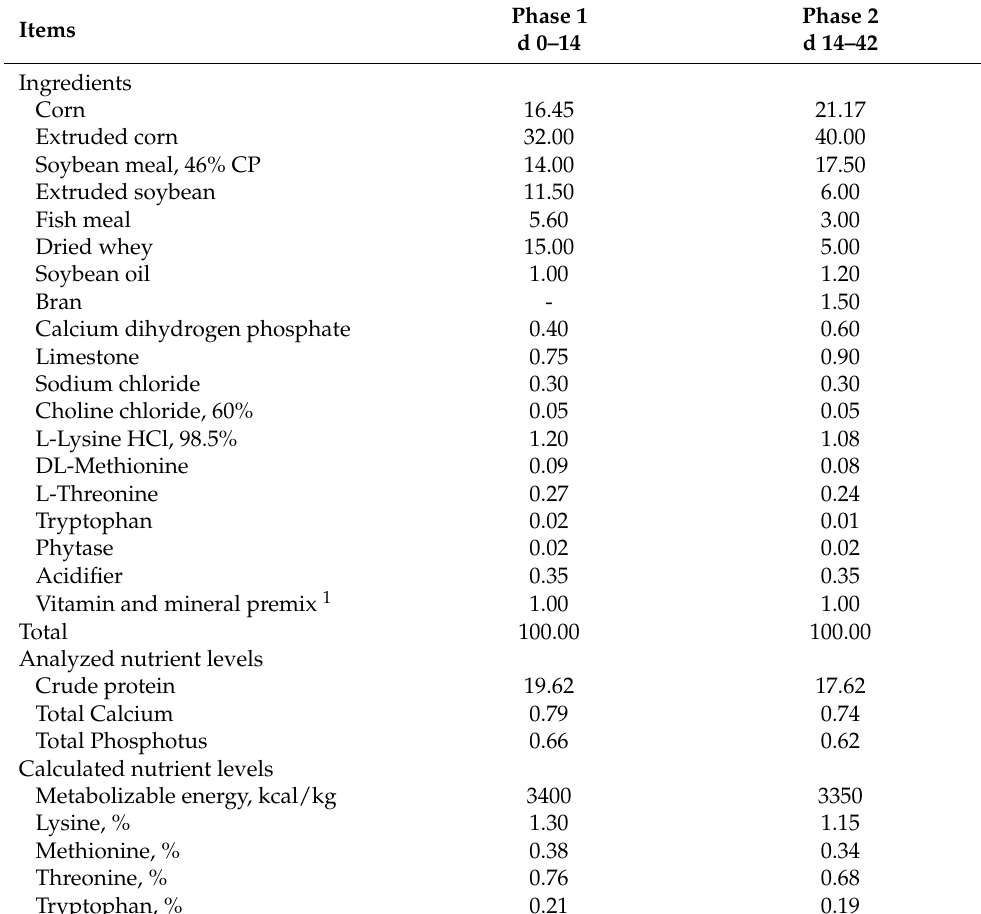
Table 2. Ingredient compositions and nutrient levels of nursery diets in phases 1 and 2 (%, as-fed